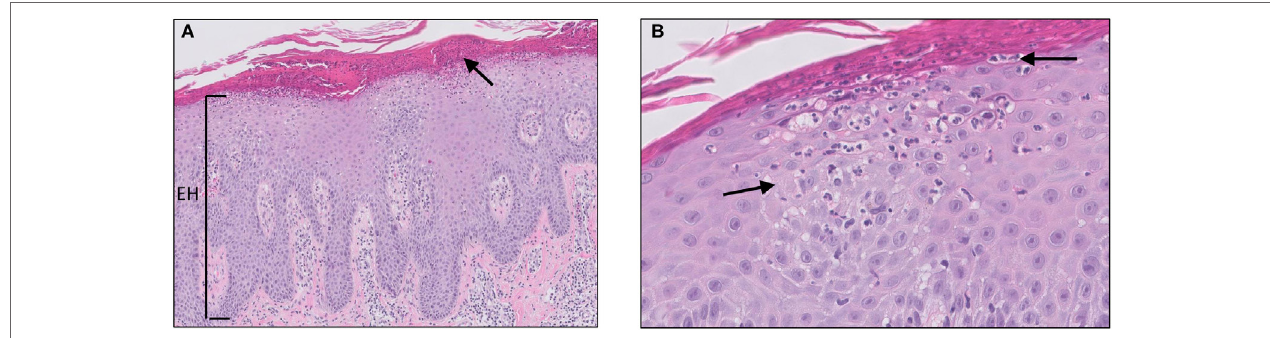
FigURe 2 | Psoriasis vulgaris. Confluent parakeratosis, psoriasiform epidermal hyperplasia [ (A) , EH], hypogranulosis, and influx of numerous neutrophils in the corneal layer [ (A) , arrow]. (B) Transepidermal migration of neutrophils from the dermis to the corneal layer